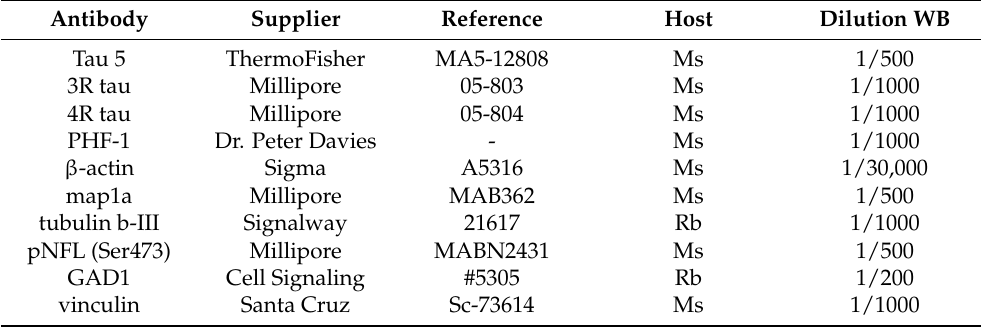
Table 2. List of antibodies used to assess protein levels by Western blotting, including the antibody’s commercial reference, the antibody’s production host, and the used Western blot